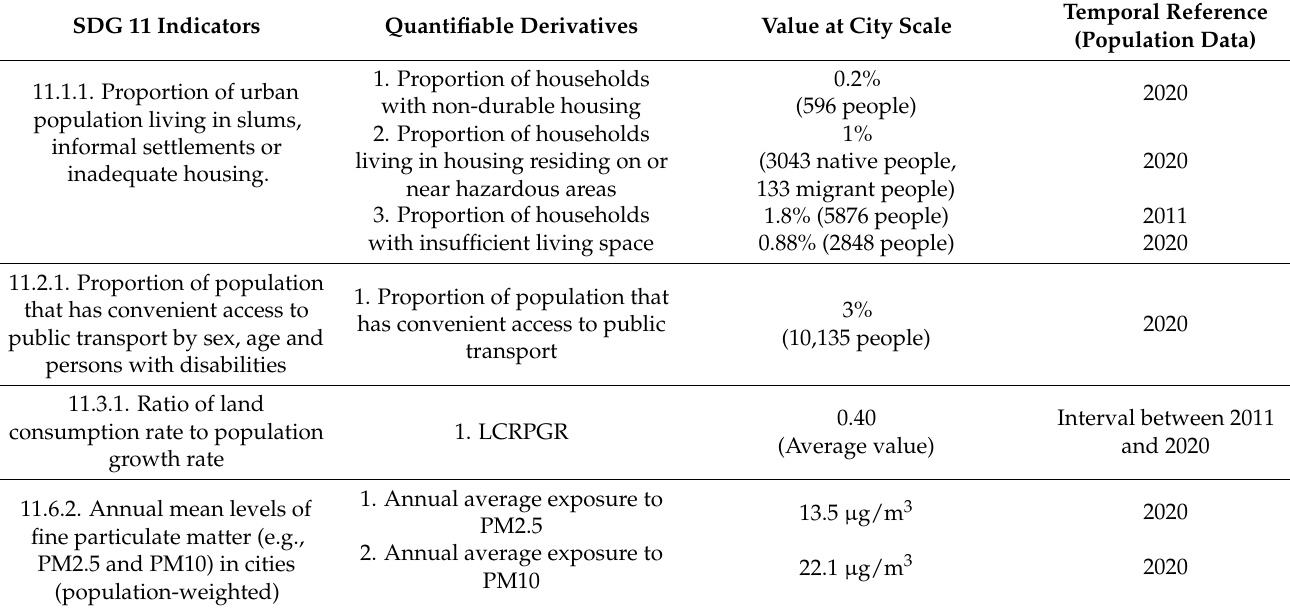
Table 6. Values of SDG 11 indicators obtained at urban scale for Bari city, for the total and migrant populations. SDG 11